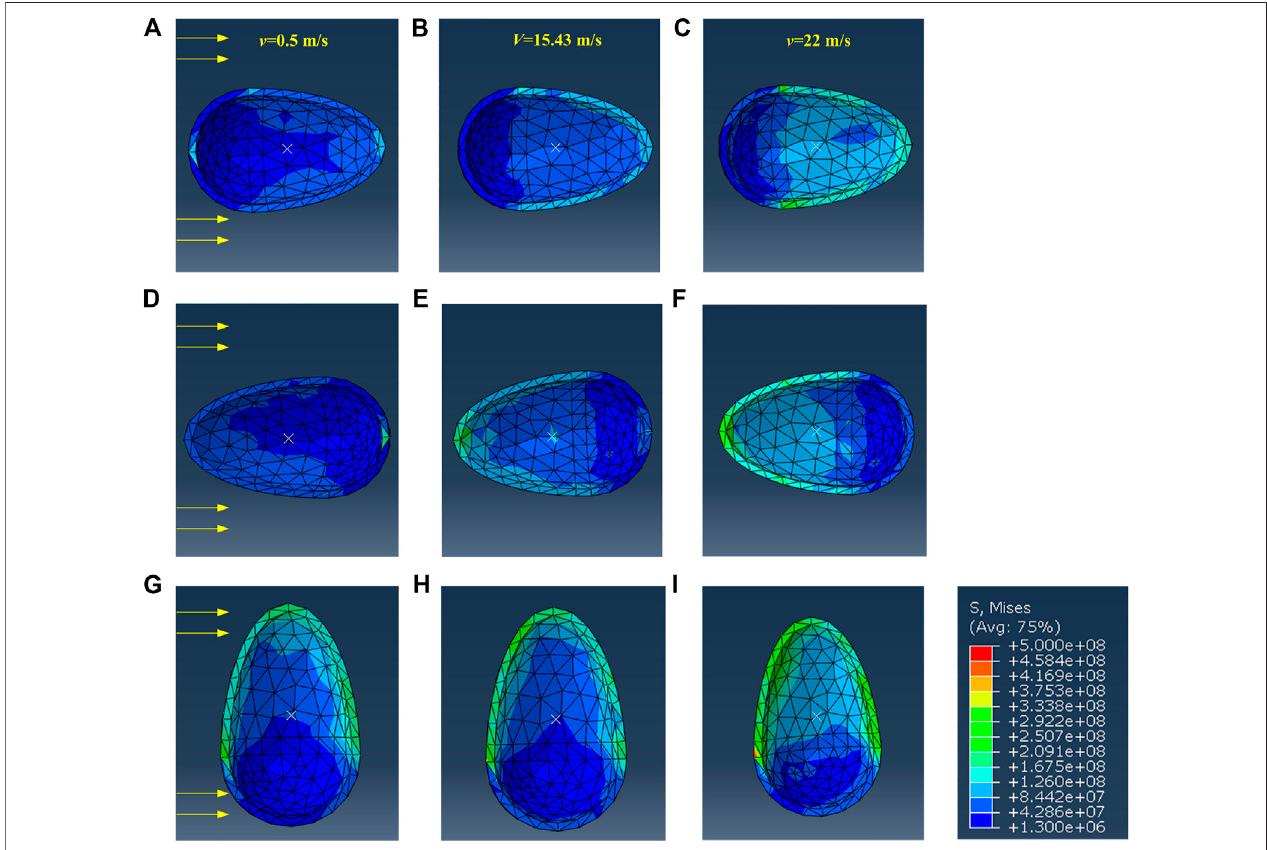
FIGURE 5 | The cloud diagram of the shell ’ s stress when the abalone faces the water fl ow with (A – C) posture 1 (D – F) posture 2 (G – I) posture 3.